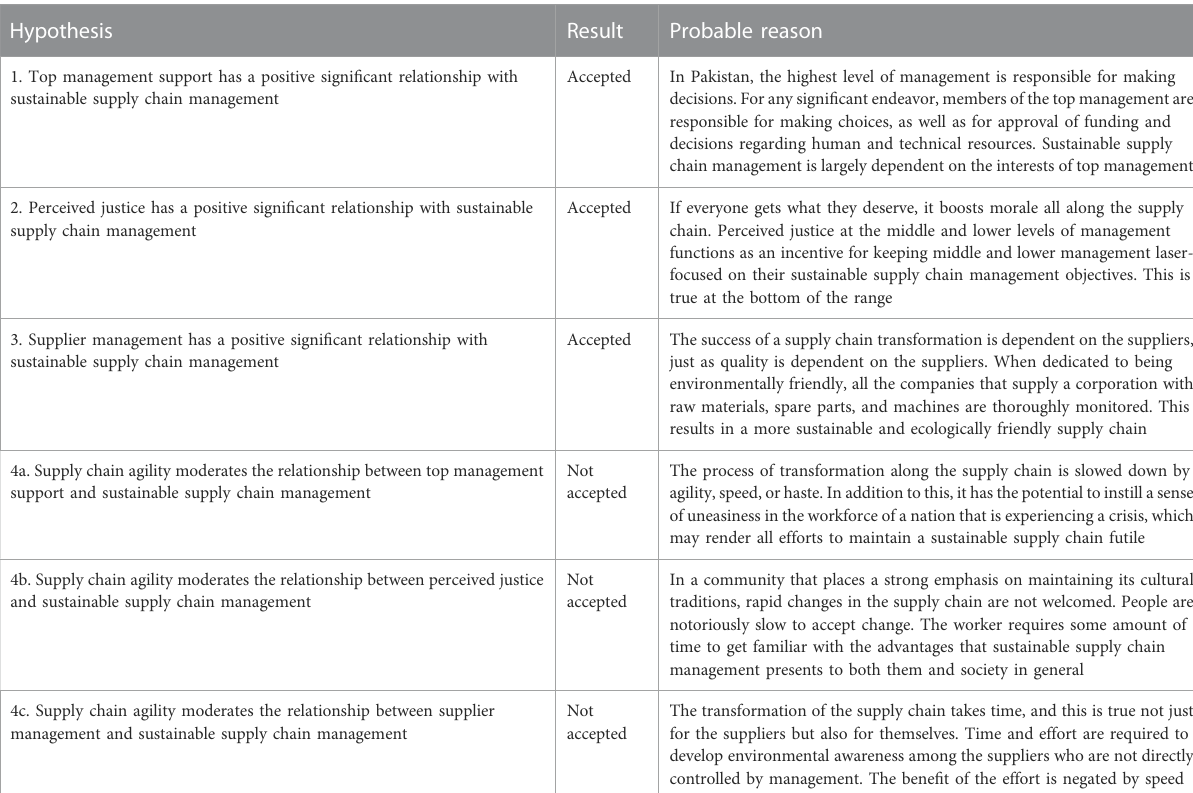
TABLE 6 Overall hypothesis